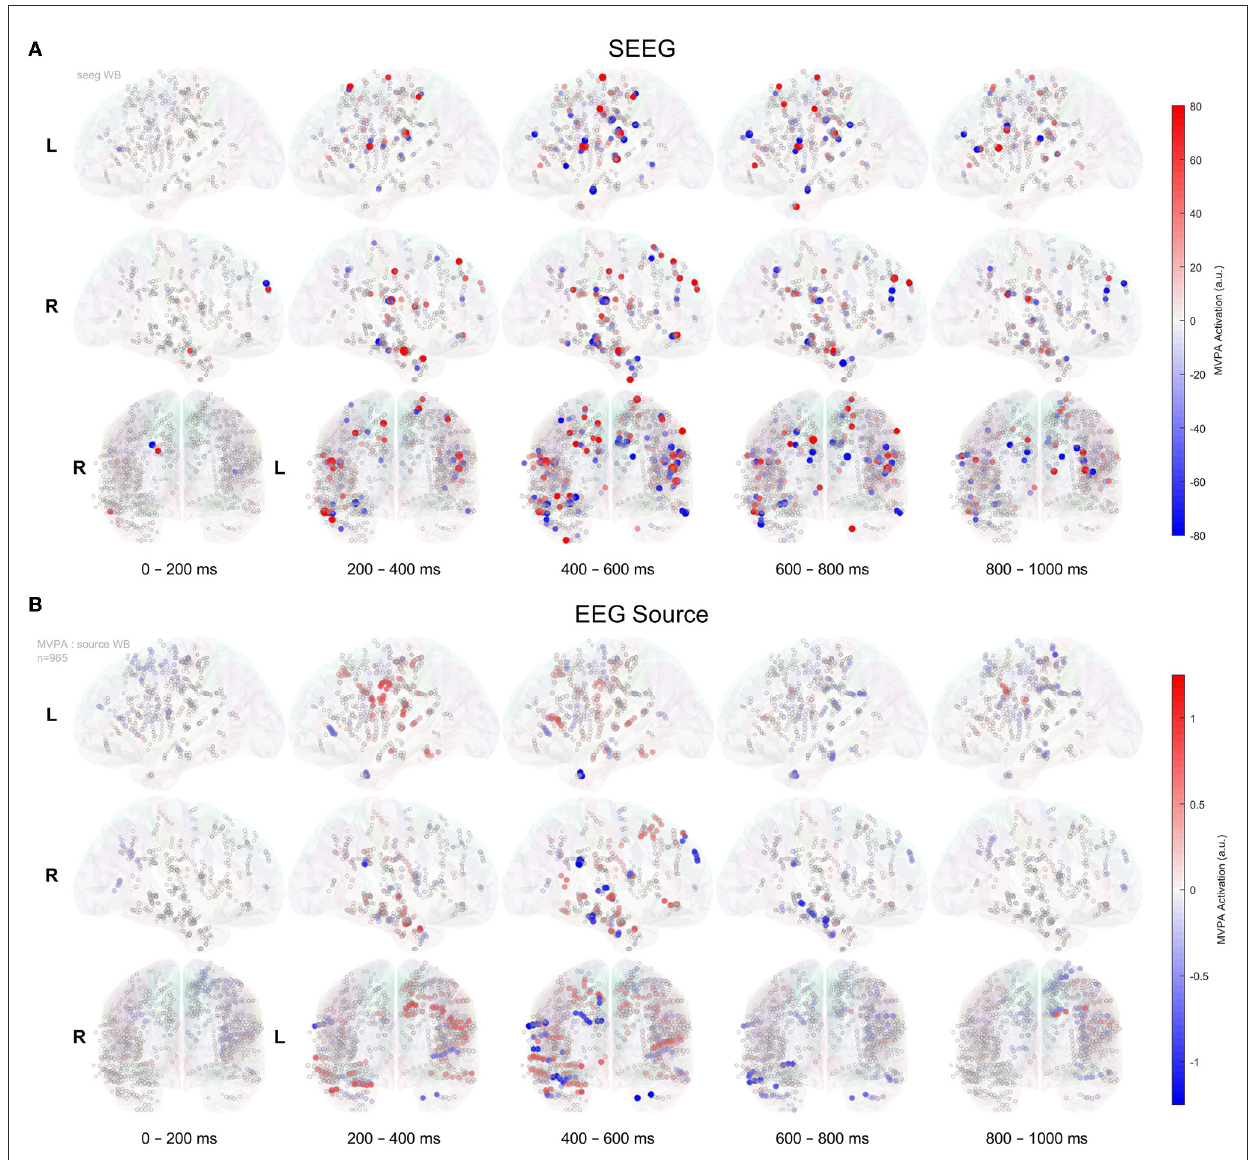
FIGURE7 MVPA timeline of activation patterns, as introduced by Haufe et al. (2014), for SEEG signals (A) and in EEG source space (B) for all 965 contacts implanted in 12 patients, shown on the glass brain. The mean of activation patterns’ values within 200ms bins is represented.